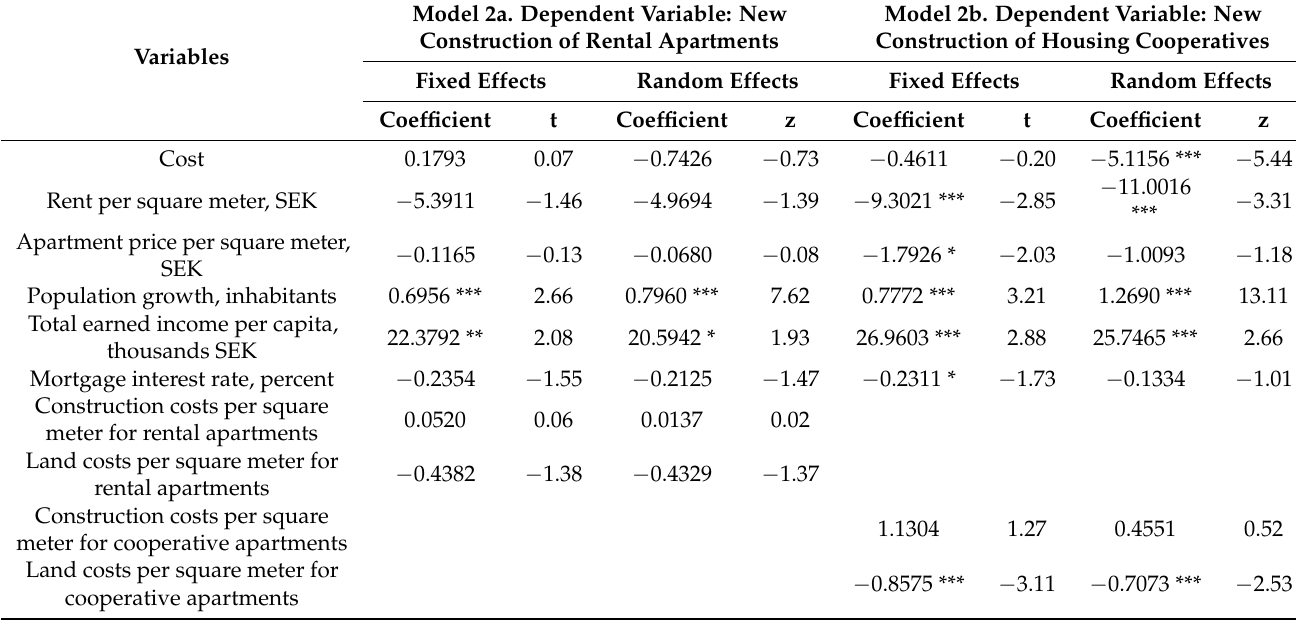
Table 5. Dynamics of the new construction of